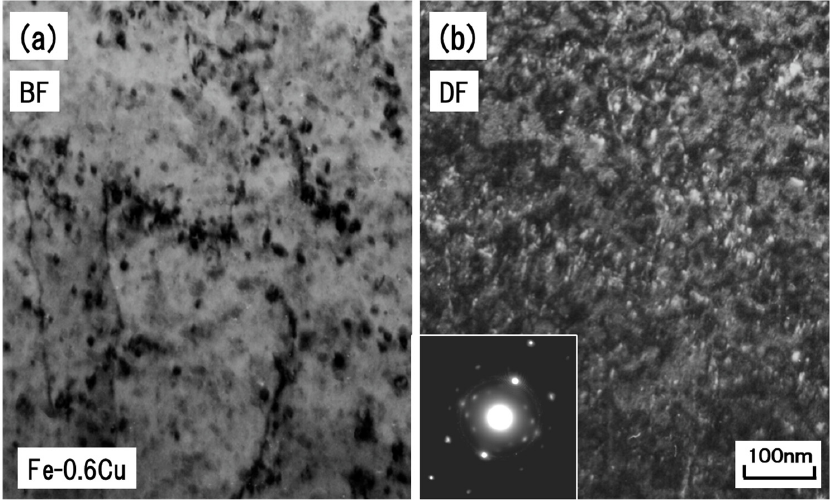
Figure 3. Bright-field ( a ) and corresponding dark-field (weak beam) ( b ) images of Fe-0.6wt%Cu alloy irradiated at 290 ◦ C with an irradiation dose of 4.1 × 10 24 n/m 2 . The diffraction pattern of (100) plane and precipitates (CRPs) were also inserted in ( b ).